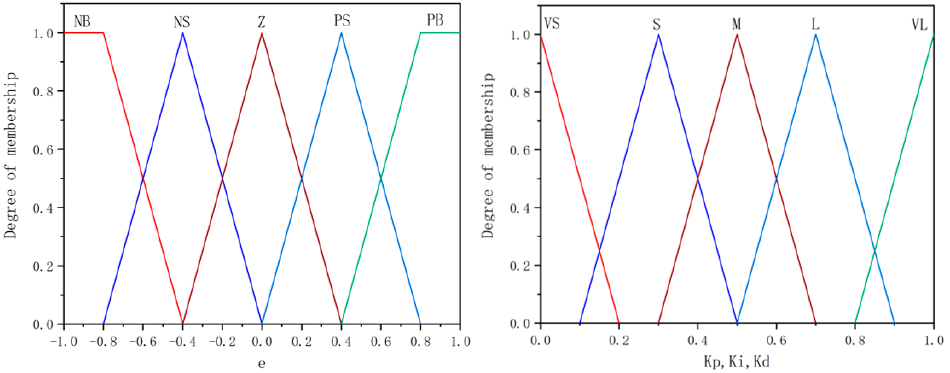
Figure 9. Structure of fuzzy logic.